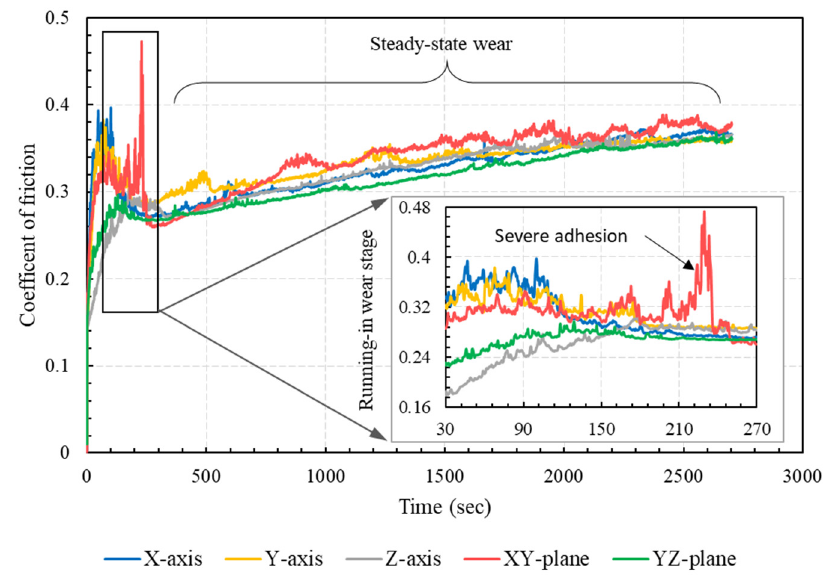
Figure 5. Coefficient of friction variation with time for different specimen orientations.